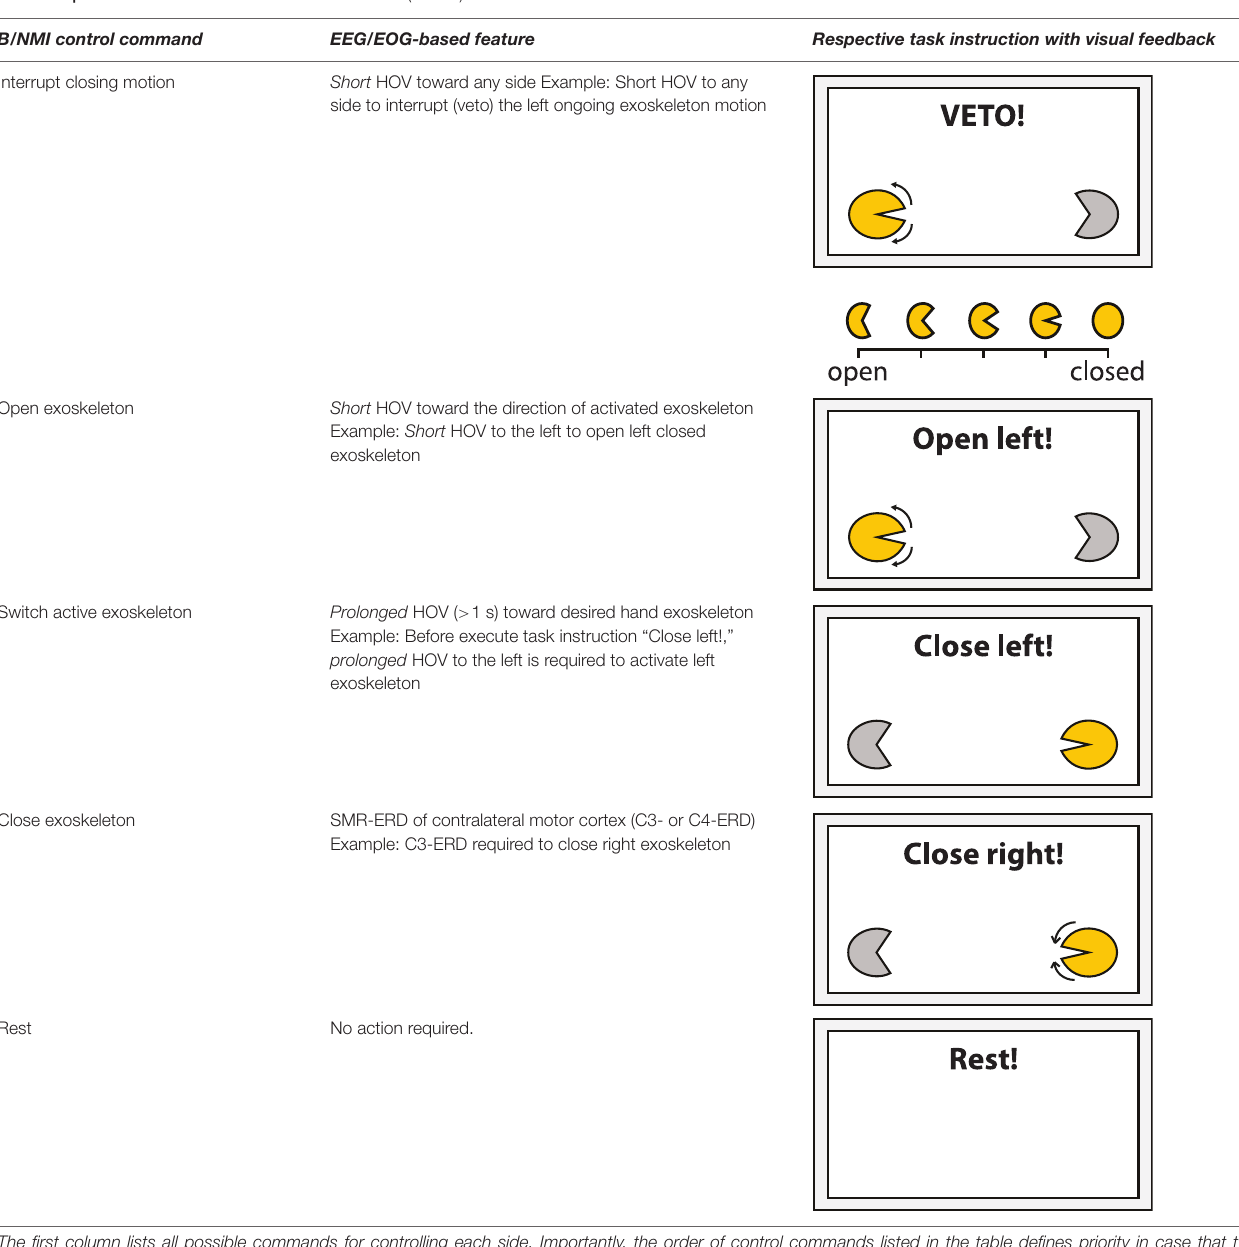
TABLE 1 | Overview of brain/neural-machine interface (B/NMI) control